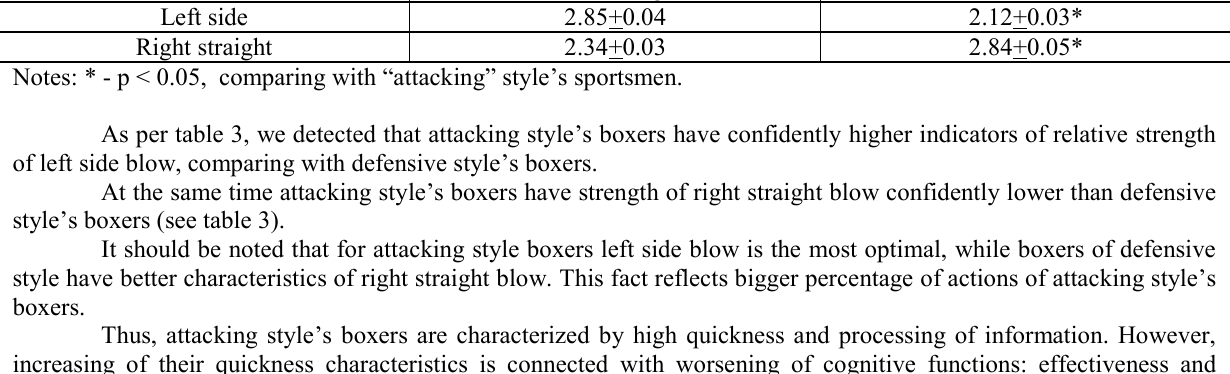
Mean values of relative power of blows of different boxing styles’ boxers. (n=22) Blows, indicators